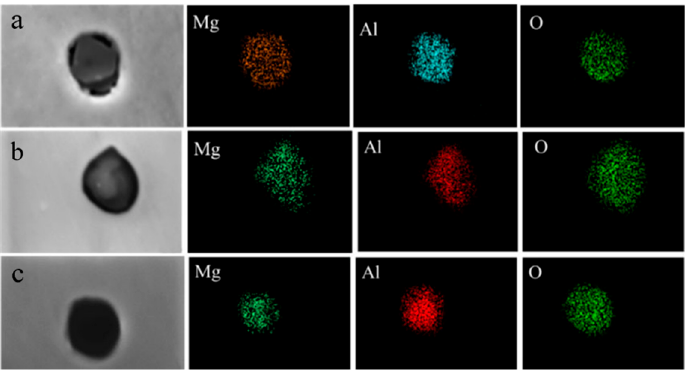
Figure 3. Morphology of typical inclusions in sample M1 (( a ): 60 s; ( b ): 300 s; ( c ): 600 s).